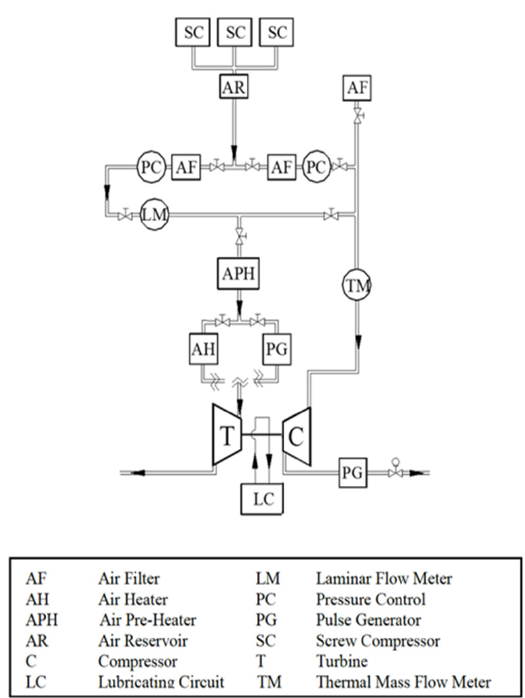
Figure 1. University of Genoa test bench. An automatic data acquisition system performs measurements through interactive procedures in the LabVIEW ® environment. Several average parameters are measured upstream and downstream of compressor and turbine. Static pressures are measured using strain-gauge and piezoresistive transducers (accuracy of ± 0.15% of full scale).